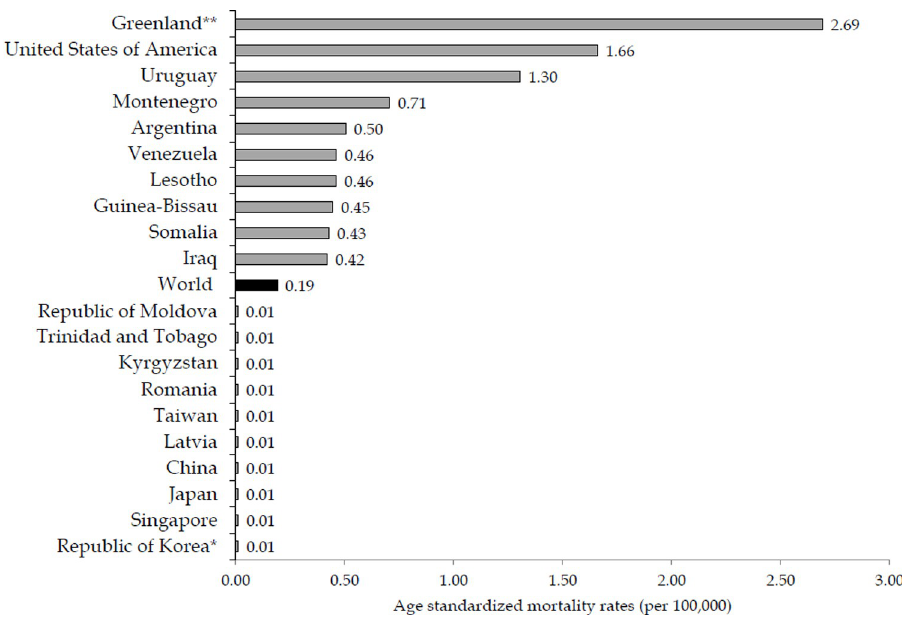
Fig 5. Suicide mortality by firearm in women, by countries: 10 highest/10 lowest rates in the world in 2019. � Country with the lowest rate; �� Country with the highest rate. Source: GBD estimates [20].